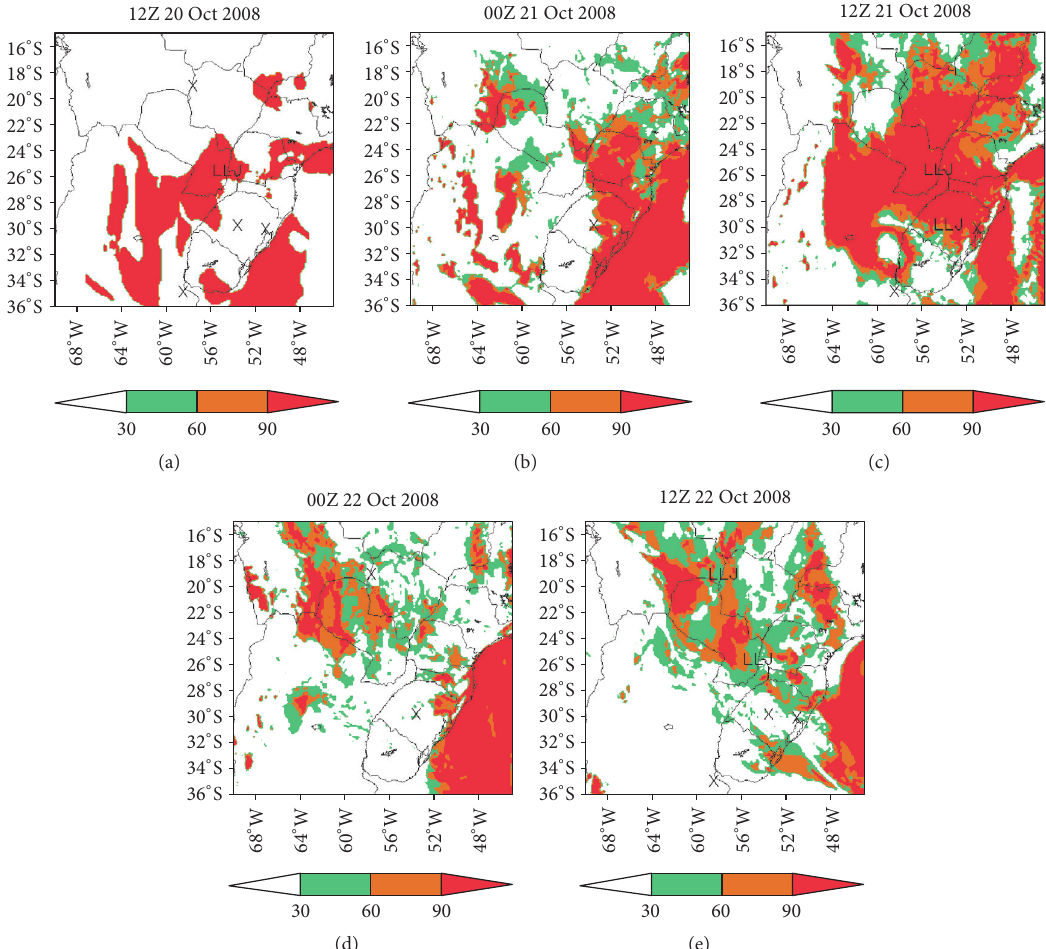
Figure 16: Time evolution of the spatial distribution of grid points from the ARW-WRF simulations where a LLJS was characterized from (a) 12Z 20 October 2008 (model initial condition) to (e) 12Z 22 October 2008 in 12hr intervals. The color shading indicates, for the corresponding grid points, the percentage number of simulations employing the MYJ PBL parameterization scheme which generated a LLJS. The shading scale is indicated on the bottom of (a)–(e). The label “LLJ” [“X”] indicates an upper air meteorological station, where a LLJS was [was not]